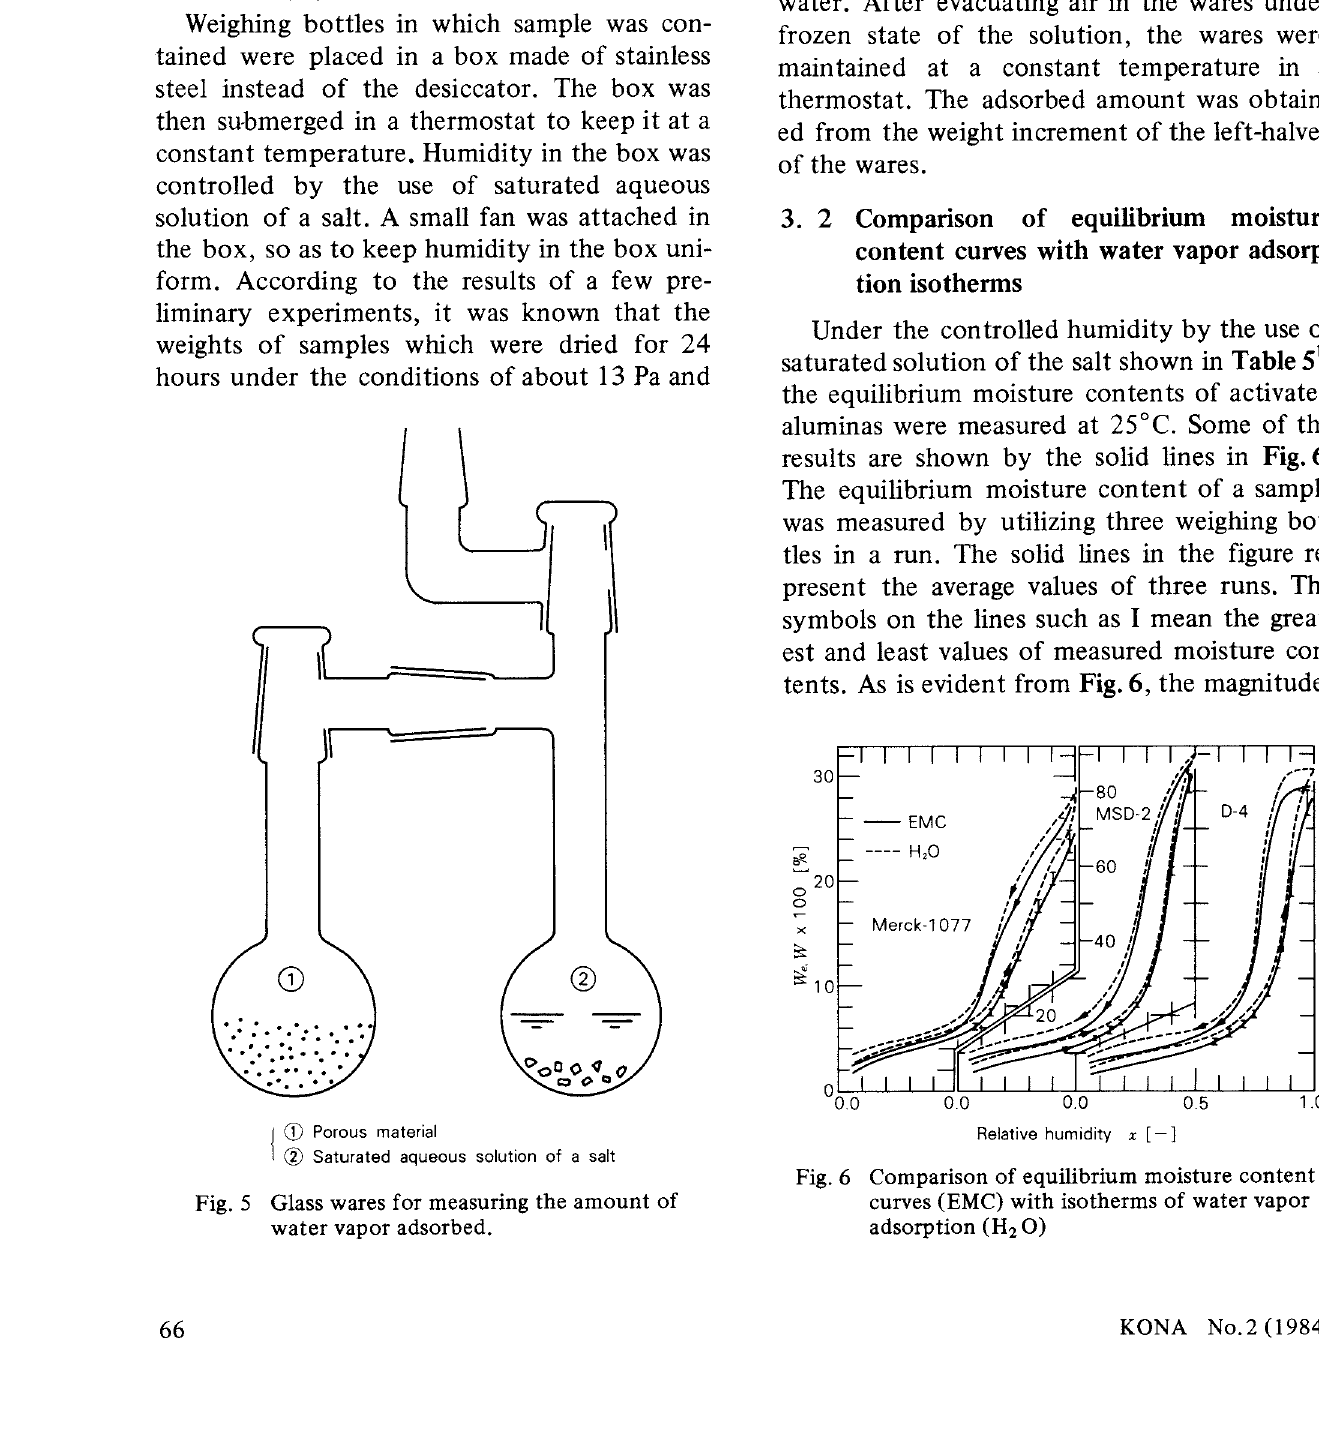
Fig. 6 Comparison of equilibrium moisture content curves (EMC) with isotherms of water vapor adsorption (H 2